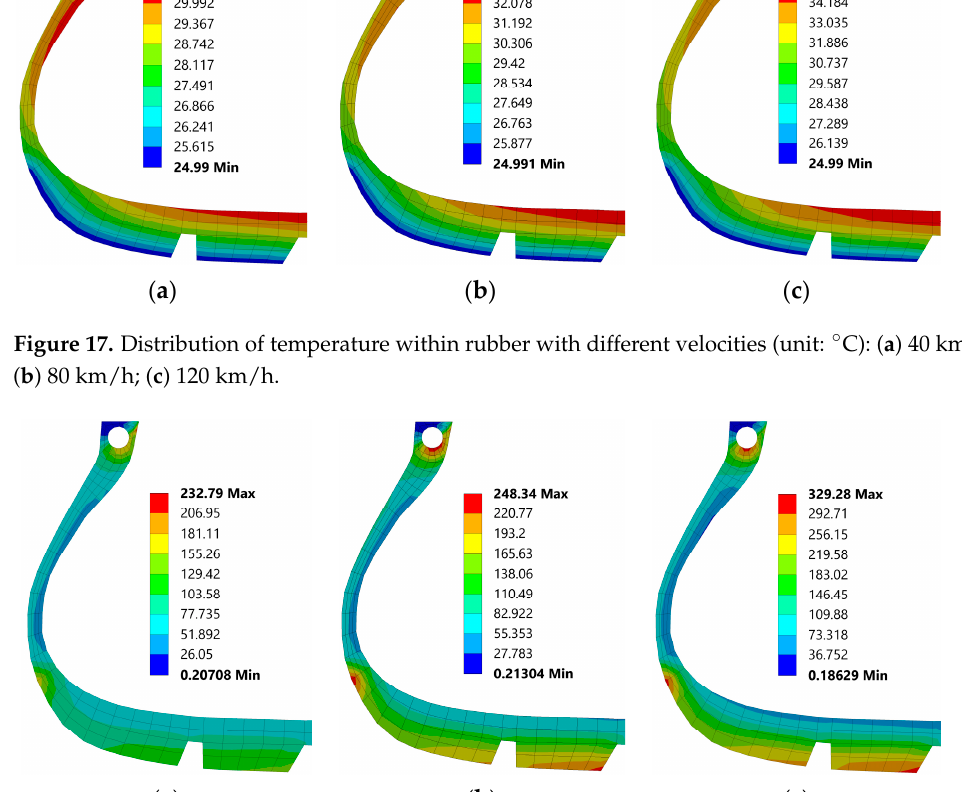
Figure 17. Distribution of temperature within rubber with di ff erent velocities (unit: °C): ( a ) 40 km/h; ( b ) 80 km/h; ( c ) 120 km/h.